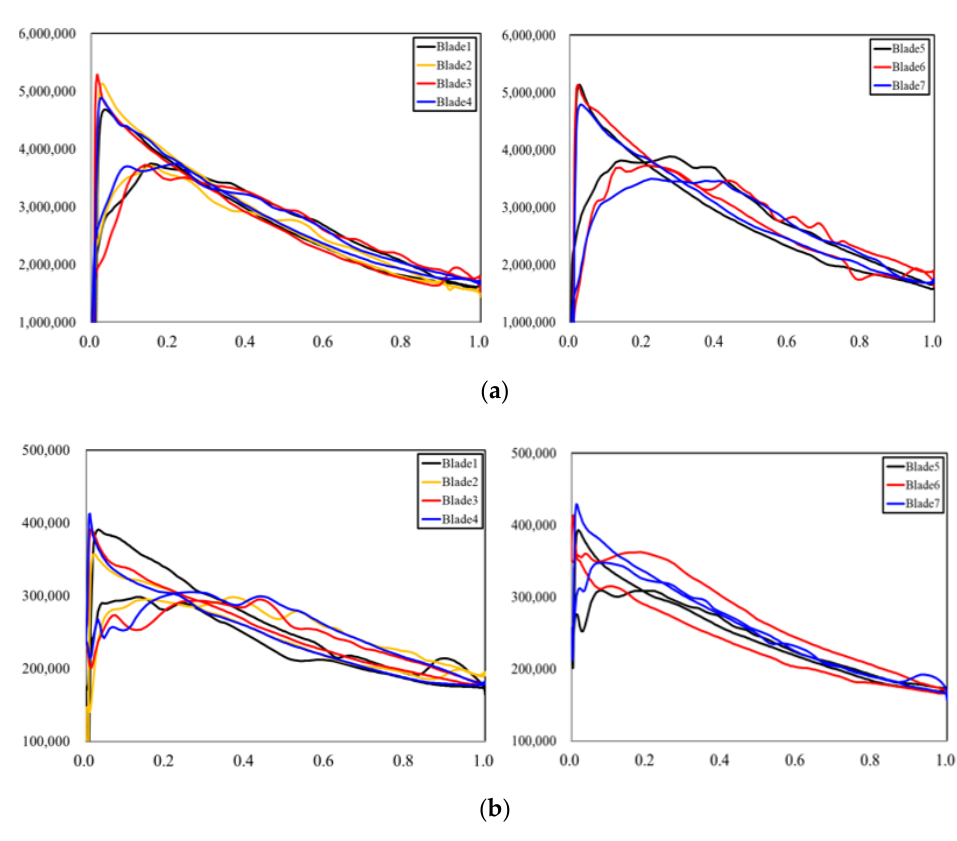
Figure 19. Comparison of the blade-loading distribution under the runaway condition: ( a ) Full-scale model (blade 1–7); ( b ) laboratory-scale model (blade